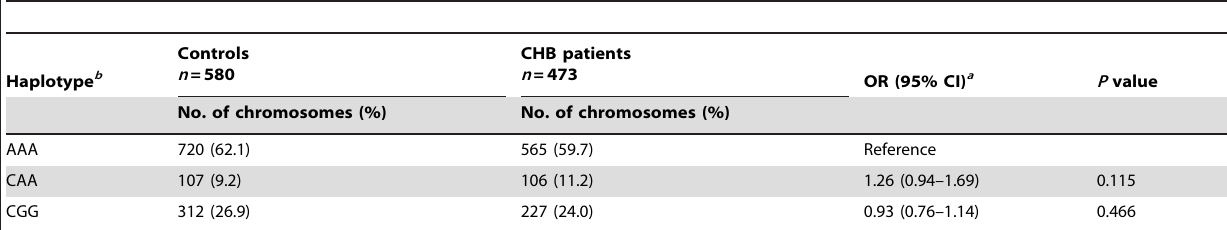
Table 3. Distribution of haplotype frequencies among CHB patients and Controls and their association with CHB in Chinese